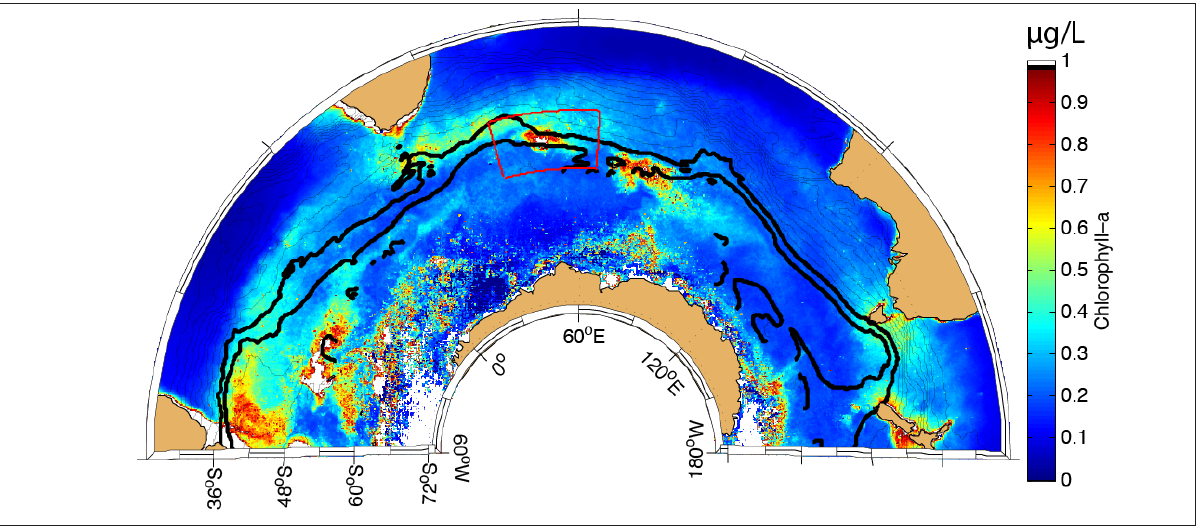
Figure 2: Chlorophyll-a concentrations (μg/L) in the Atlantic and Indian sectors of the Southern Ocean for the austral summer, derived from SeaWifs satellite data averaged for 1997–2004 (spatial grid resolution of 1 degree, nominal temporal resolution of 8 days). Chlorophyll-a is a green pigment used by all phytoplankton for light absorption during oxygenic photosynthesis; the distribution of surface ocean chlorophyll-a can thus be used as a proxy for phytoplankton productivity. The black contours represent streamlines of the mean dynamic topography, computed from the Rio-09 New CNES-CLS09 product and used as a proxy for large-scale geostrophic currents. Bold contours show the core of the Antarctic Circumpolar Current (ACC). The red box indicates the location of the remote South African Prince Edward Islands, where land–ocean interactions will be investigated as part of ACE Project XII. High microbial primary productivity can be inferred from the high chlorophyll-a concentrations around the islands and shallow banks and along the subtropical